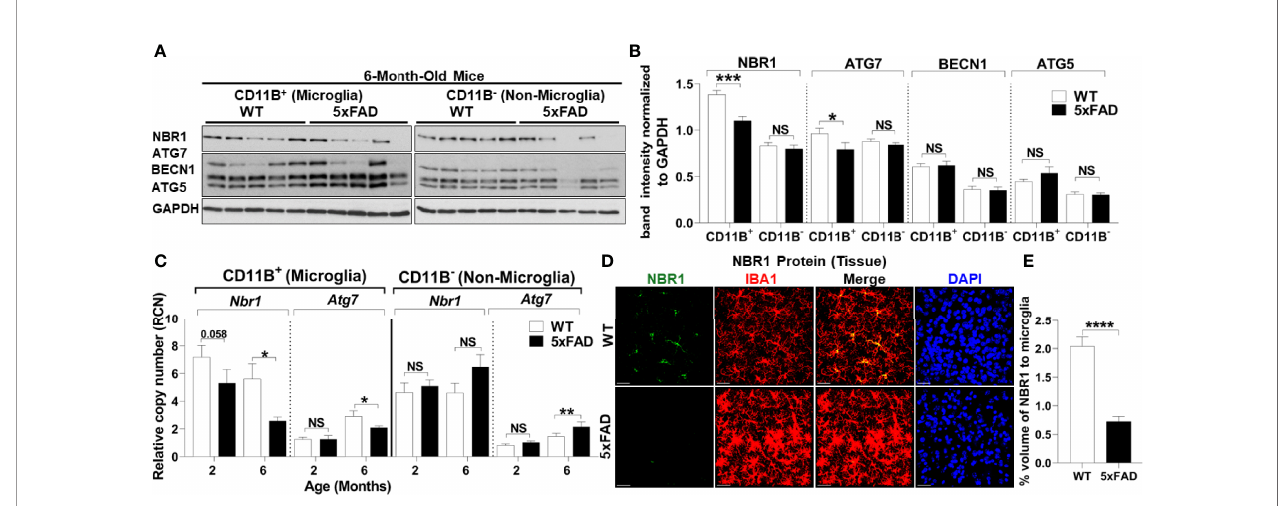
FIGURE 2 | 5xFAD microglia exhibit reduced expression of NBR1 and to a lesser extent Atg7 autophagy proteins at 6 months. (A) NBR1, ATG7, BECN1, ATG5 and GAPDH immunoblot of primary microglia (CD11b + ) and non-microglia (CD11b - ) fractions of 6-month old 5xFAD and sex- and age-matched wild-type (WT) littermate brains (n = 5). (B) Densitometry analysis of immunoblots represented in (A) . Data represent mean ± SEM (n = 5). Statistical analysis was performed using unpaired two-tailed student ’ s t-test. (C) Relative copy number of Nbr1 and Atg7 in primary microglia (CD11b+) or non-microglia (CD11b-) fractions of 2 and 6 month old 5xFAD and sex- and age-matched wild-type (WT) littermate brains (n = 9 for 2 month and n = 12 for 6 month). Statistical analysis was performed using mixed-effect analysis. (D) Representative confocal images of NBR1 protein (green) expression on brain tissue sections stained for IBA1+ microglia (red) from 6-month old 5xFAD and age-matched WT littermates. (E) Quanti fi cation of images represented in (D) was analyzed by Imaris software (n = 3). Statistical analysis was performed by unpaired student t-test. *p ≤ 0.05, **p ≤ 0.01, ***p ≤ 0.001, ****p ≤ 0.0001, NS, Not Signi fi